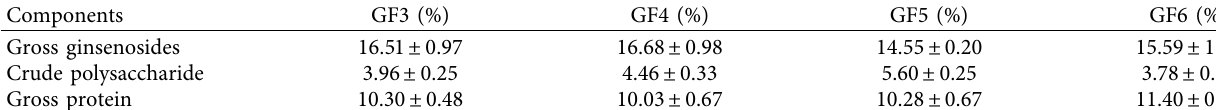
Table 2: Te contents of gross ginsenosides, crude polysaccharide, and gross protein in GFs of various ages ( n � 3).